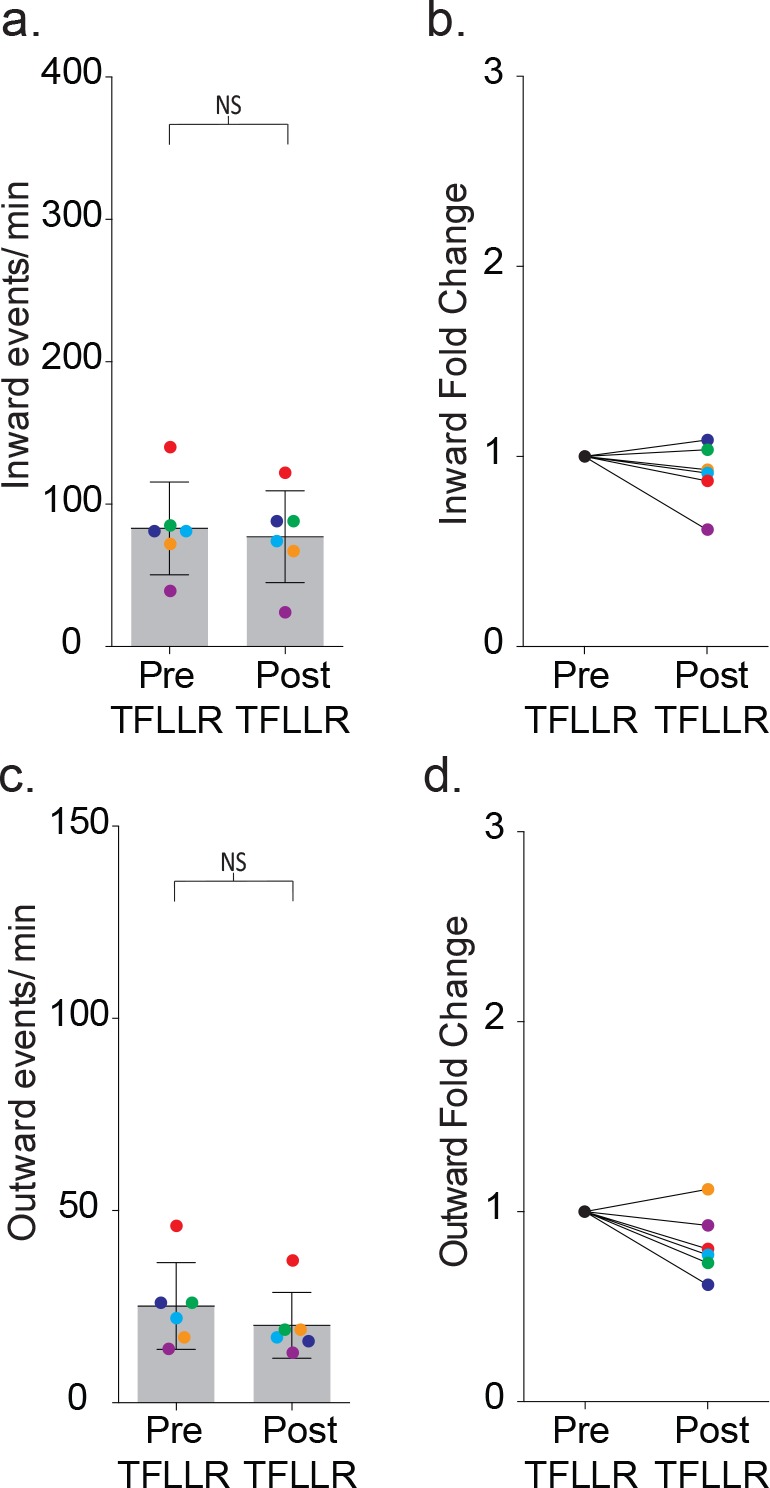
The relative contributions of inward and outward currents following TFLLR activation in MeCP2 null barrel cortex.Low intracellular chloride concentrations were used while neurons were held at −35 mV. (a) The frequency of inward events was quantified before and after 500 μM TFLLR application (mean ± SD, p=0.25, n = 6, 2 males, Wilcoxon matched-pairs signed rank test, two-tailed). (b) The fold change in event frequency is shown for individual color-coded recordings. (c) The frequency of outward events was quantified before and after 500 μM TFLLR application (mean ± SD. p=0.09, n = 6, 2 males, Wilcoxon matched-pairs signed rank test, two-tailed). (d) The fold change in event frequency for the individual color-coded recordings.